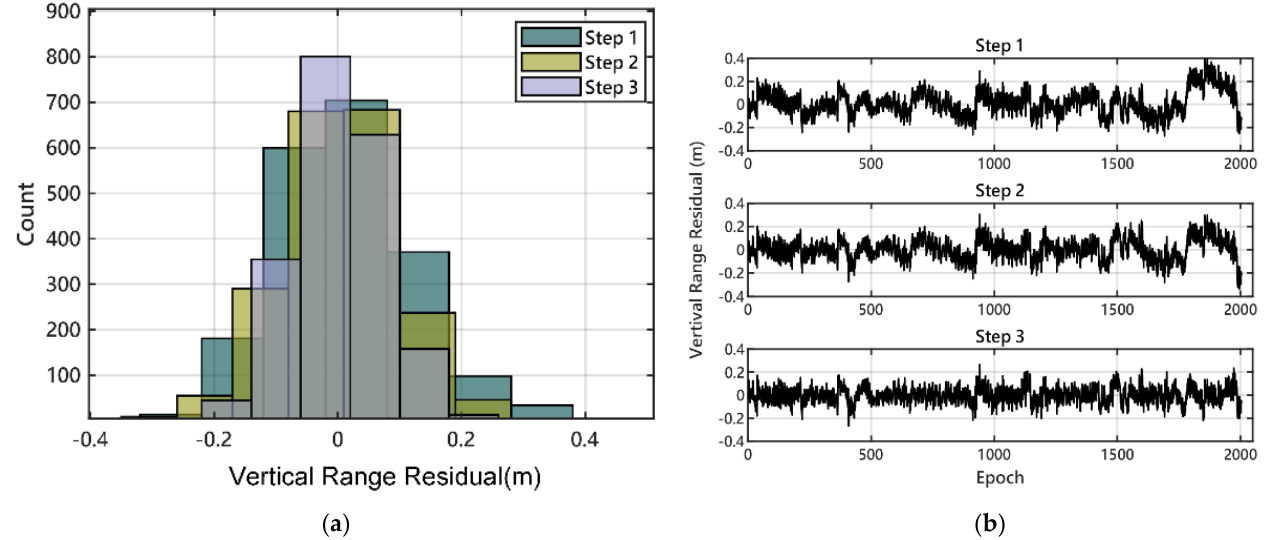
Figure 13. The histogram of vertical range residual with different iterations ( a ). The vertical range residual with different iterations ( b ).